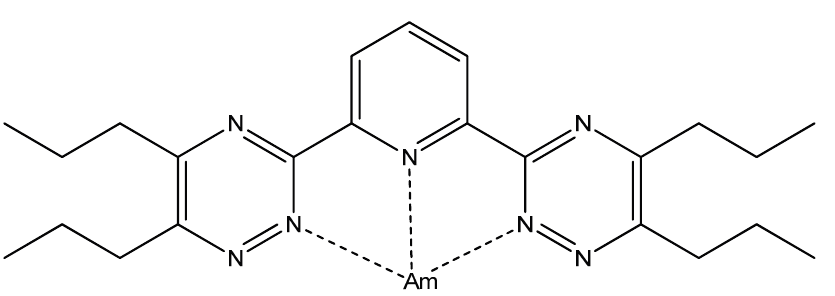
Figure 9. Structure of Am( n -PrBTP) 33+ complex.